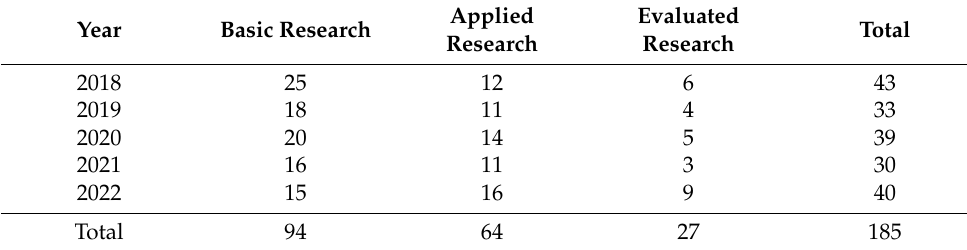
Table 8. Use of research